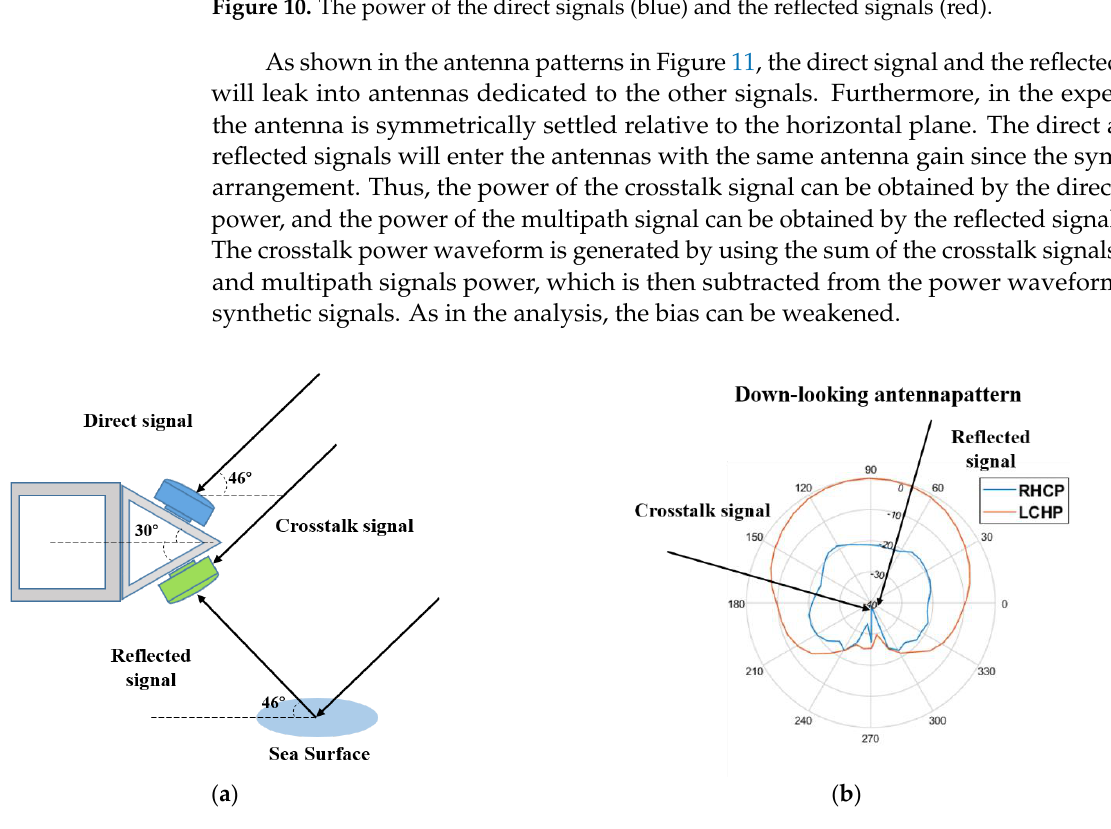
Figure 11. The sketch of the received signals: ( a ) the incident angle of the direct, reflected, and crosstalk signals, ( b ) the antenna pattern dedicated to the reflected signals.